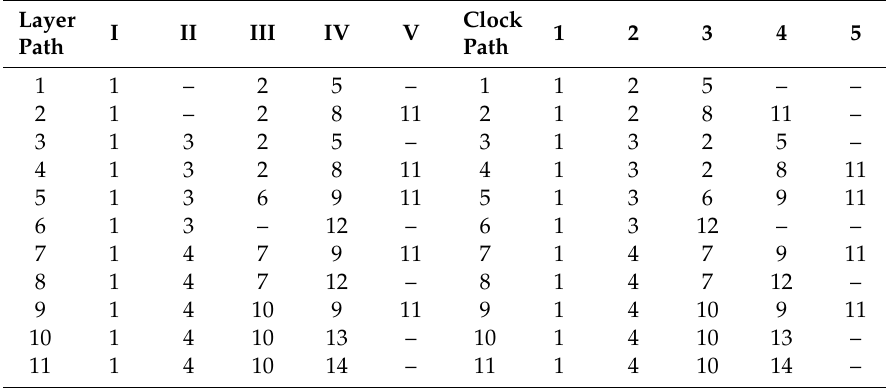
Table 3. Defined layers and paths in the ordered